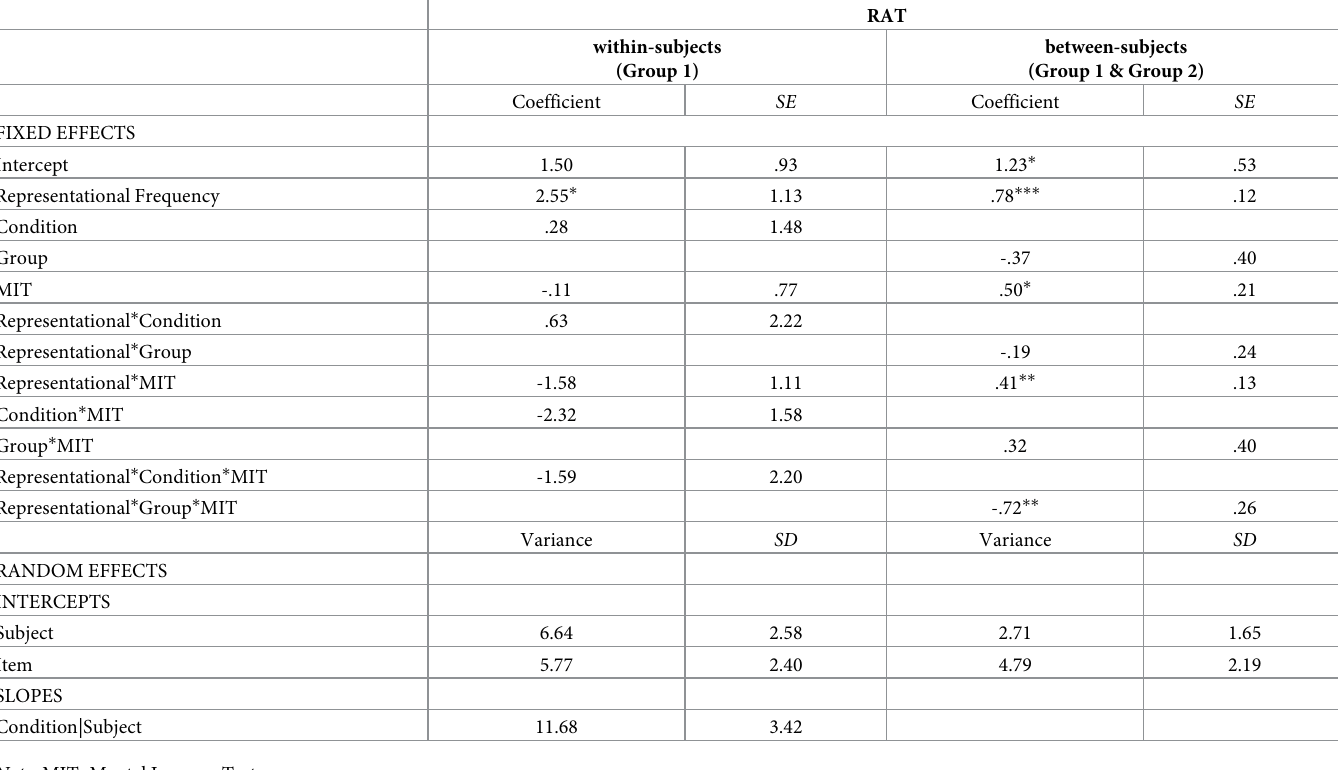
Table 5. Model summary for Hypothesis 2—Representational